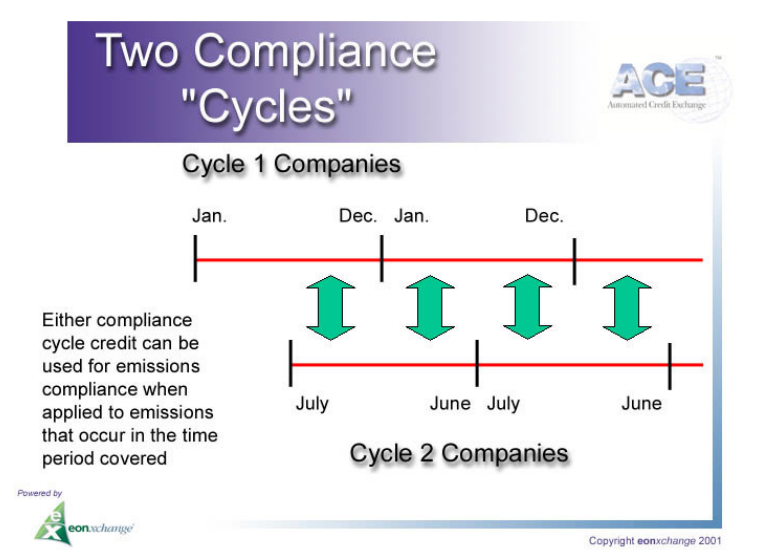
FIGURE 7. Two compliance